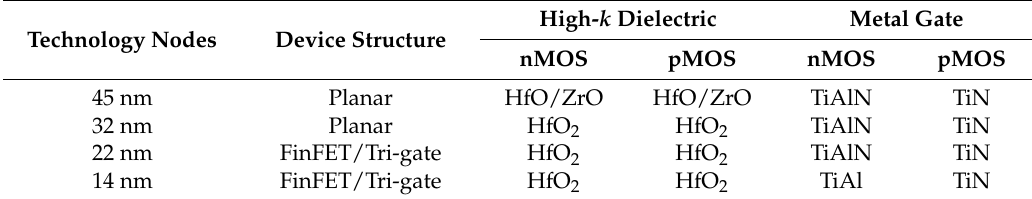
Table 3. Material selection of high- k dielectric and metal gate from 45 nm to 14 nm nodes. High- k Dielectric Metal Gate Technology Nodes Device Structure nMOS pMOS